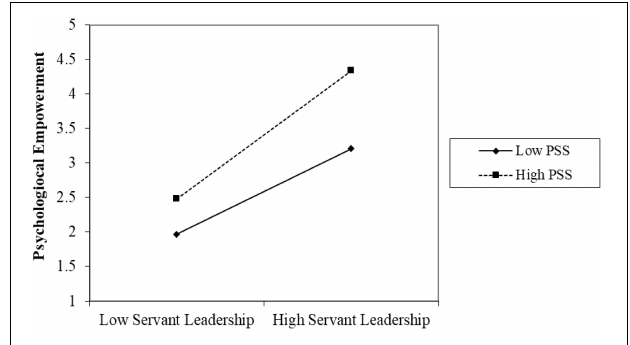
FIGURE 3 | SL × PSS = Psychological empowerment.